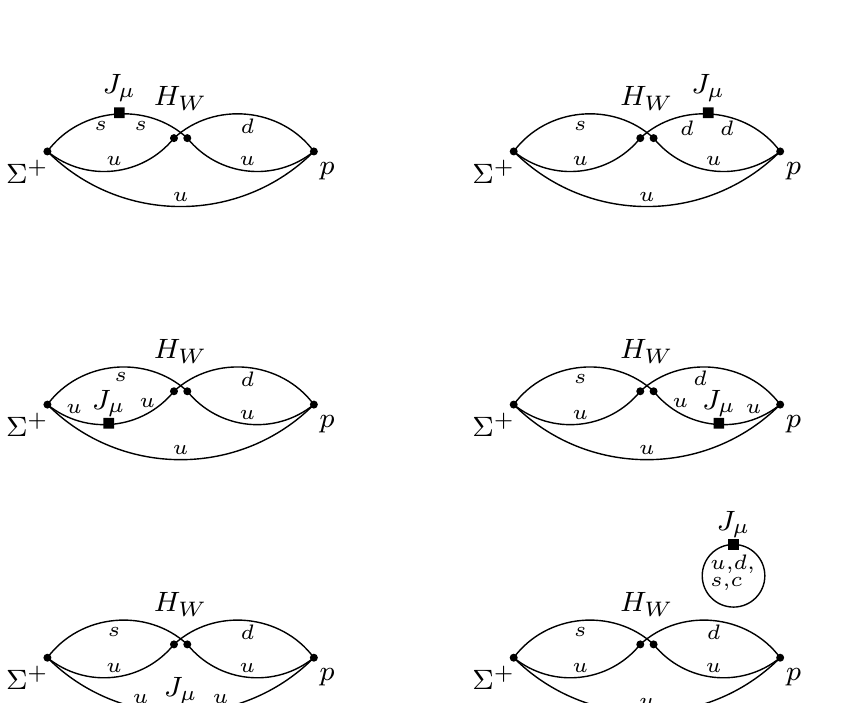
Figure 4 . Four-point diagrams for the C su class. The squared vertex shows the insertion of the electromagnetic current J µ